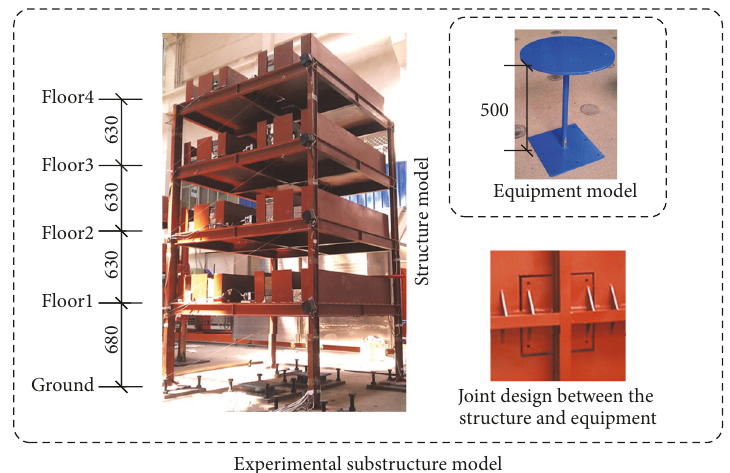
Figure 4: Model of the experimental